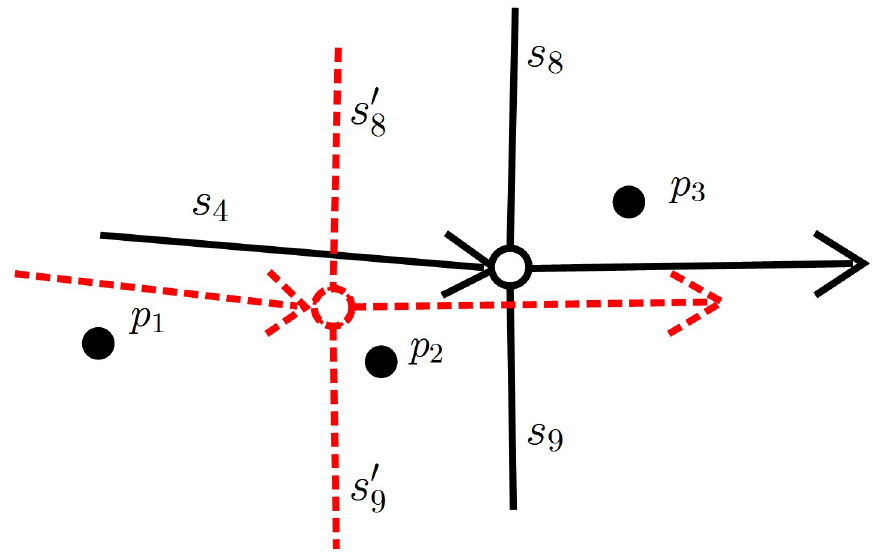
Fig 7. Translation error of the road network